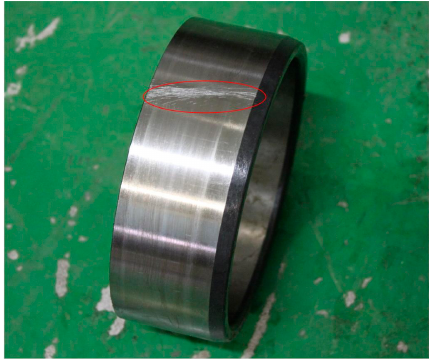
Figure 9. The inner ring fault bearing.